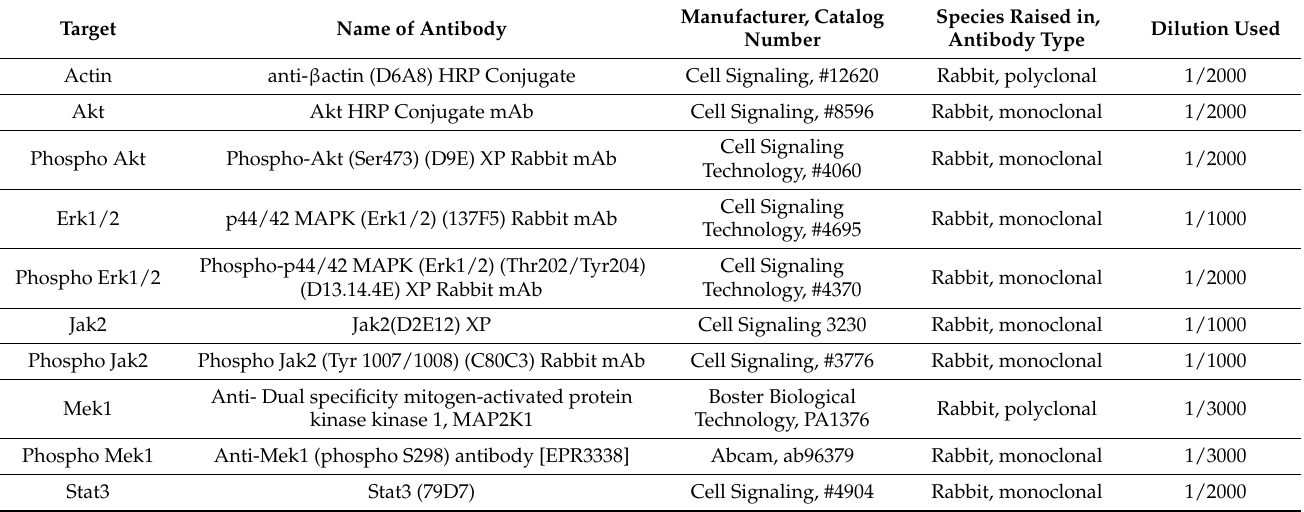
Table 2. Primary and secondary antibodies used for Western blot